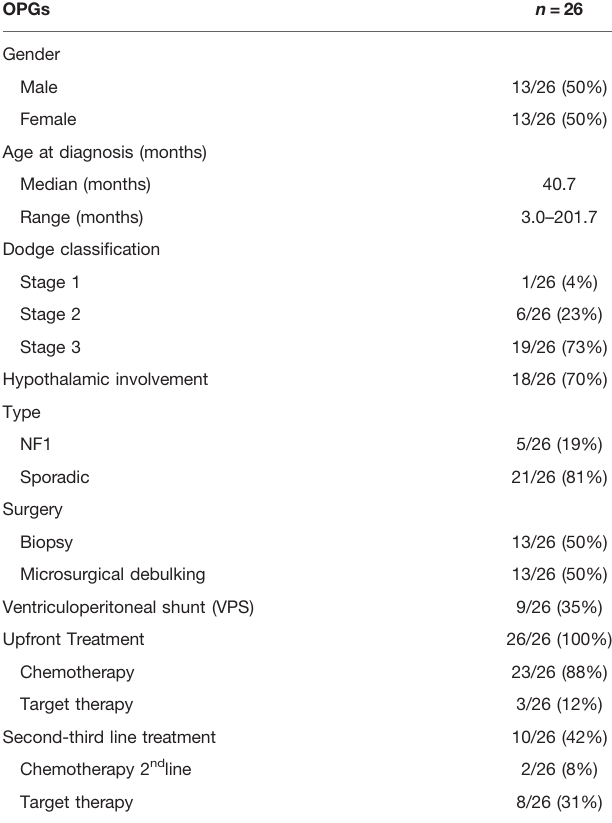
TABLE 1 | Population